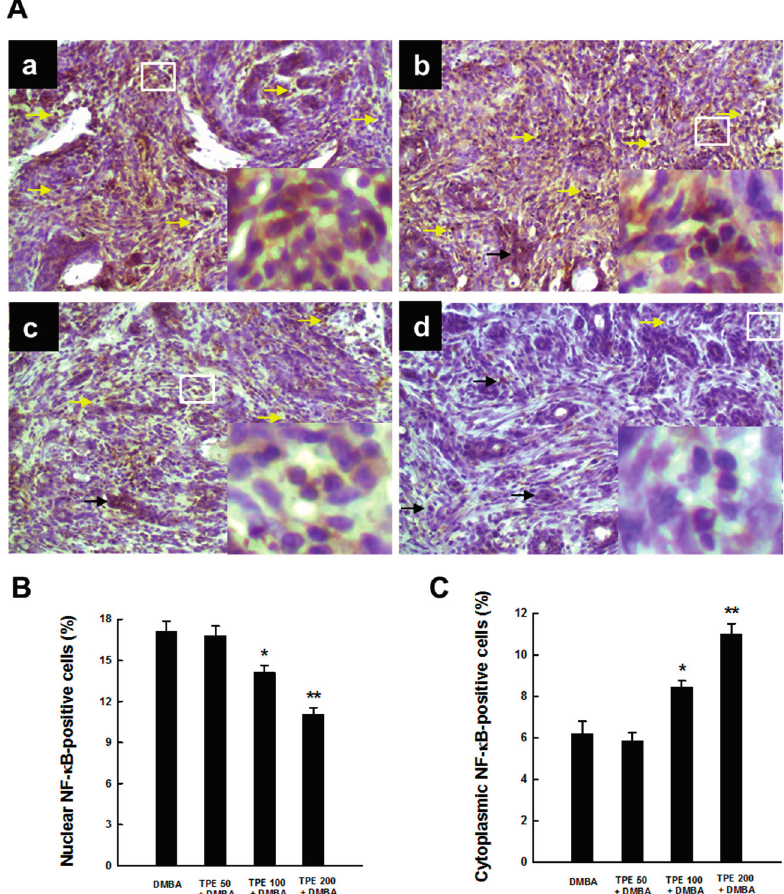
Figure 3. Effect of TPE on NF- κ B p65 activation during DMBA-induced mammary gland carcinogenesis in female Sprague-Dawley rats. The animals were treated as indicated in